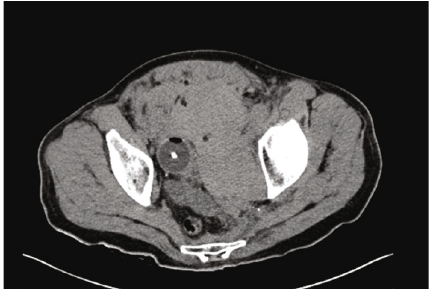
Figure 3: CT pelvis with cystogram at our hospital (axial): displaced bladder; poor cystogram without extravasation.